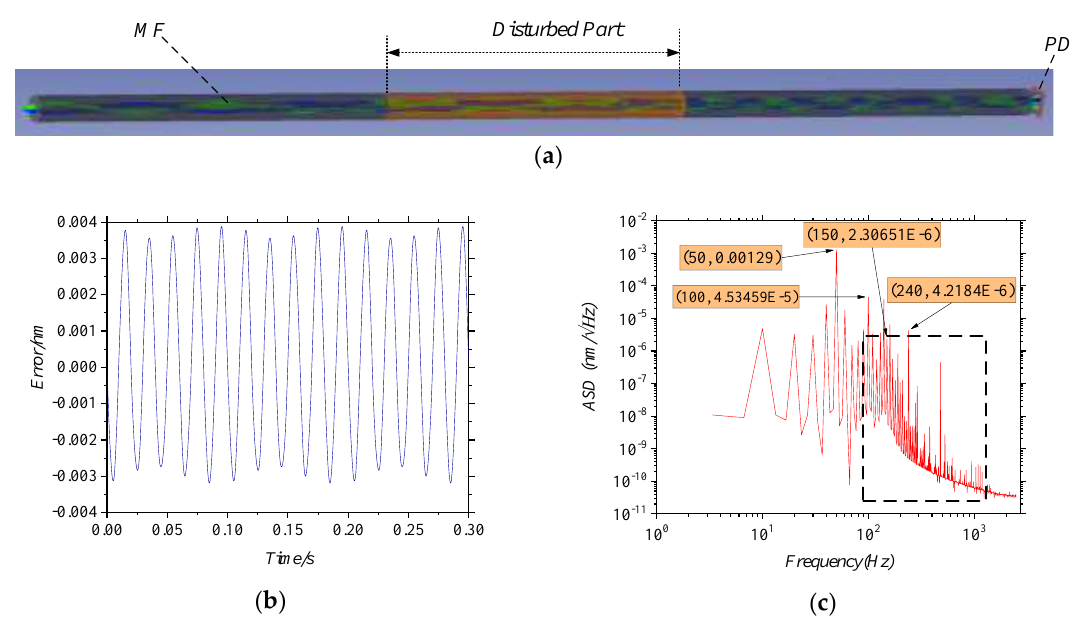
Figure 3. ( a ) The ZEMAX model of MMF; In ( a ), The disturbed part is the middle section of optical fiber. ( b ) the graph of the measurement error and time when the MMF is disturbed; ( c ) the graph of the amplitude spectral density of the measurement